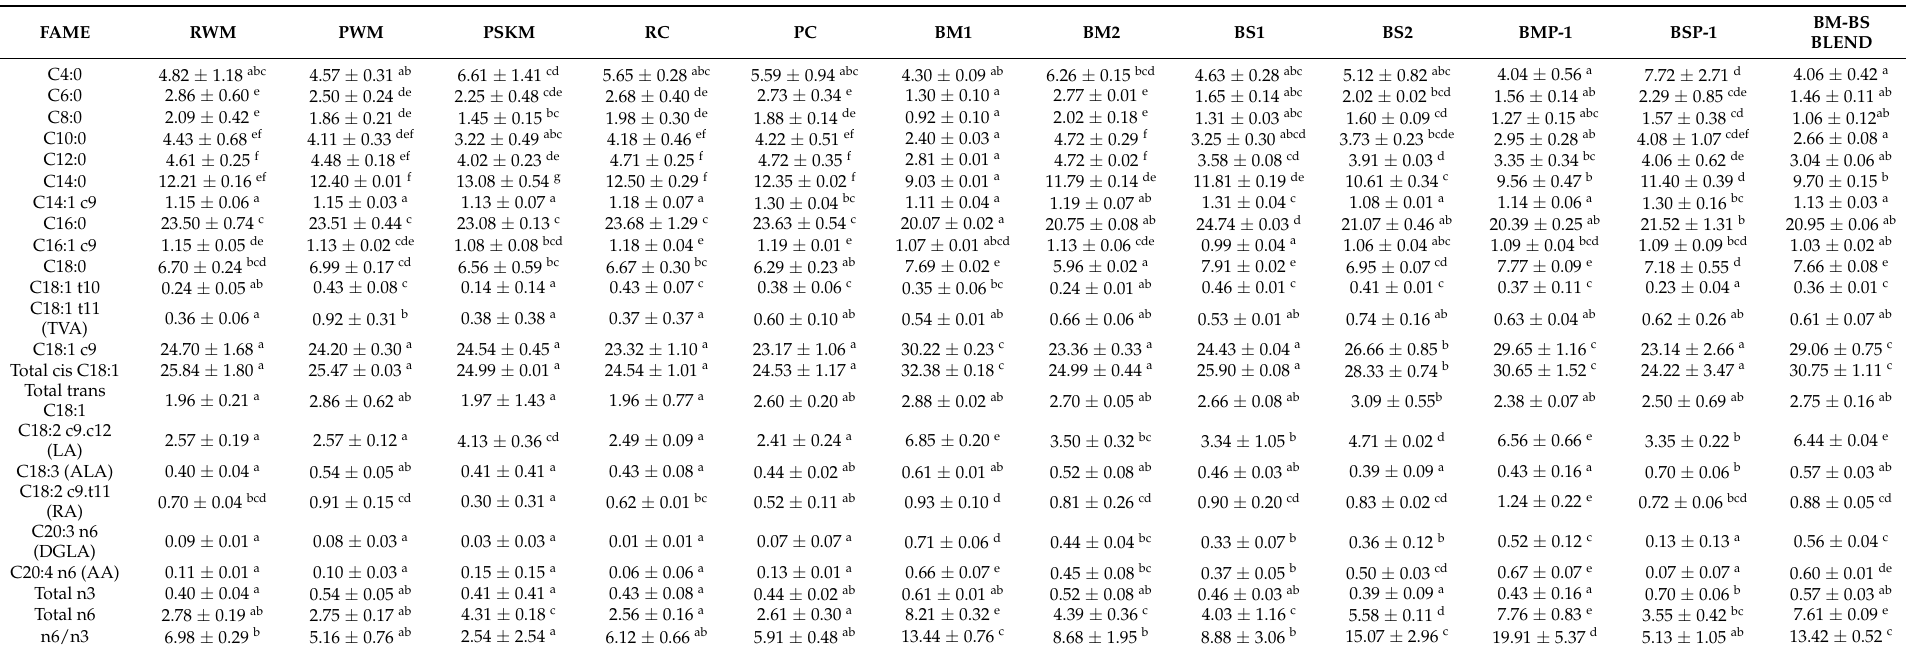
Table 2. Mean values of fatty acid methyl esters (FAMEs) of the milk, cream and by-product samples of the butter and butter oil manufacturing process.